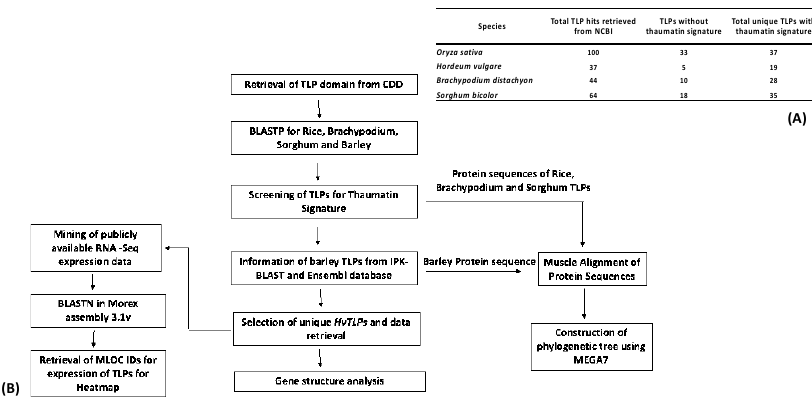
Figure 1. ( A ) Number of thaumatin-like protein ( TLP ) genes in rice, barley, Brachypodium and sorghum.